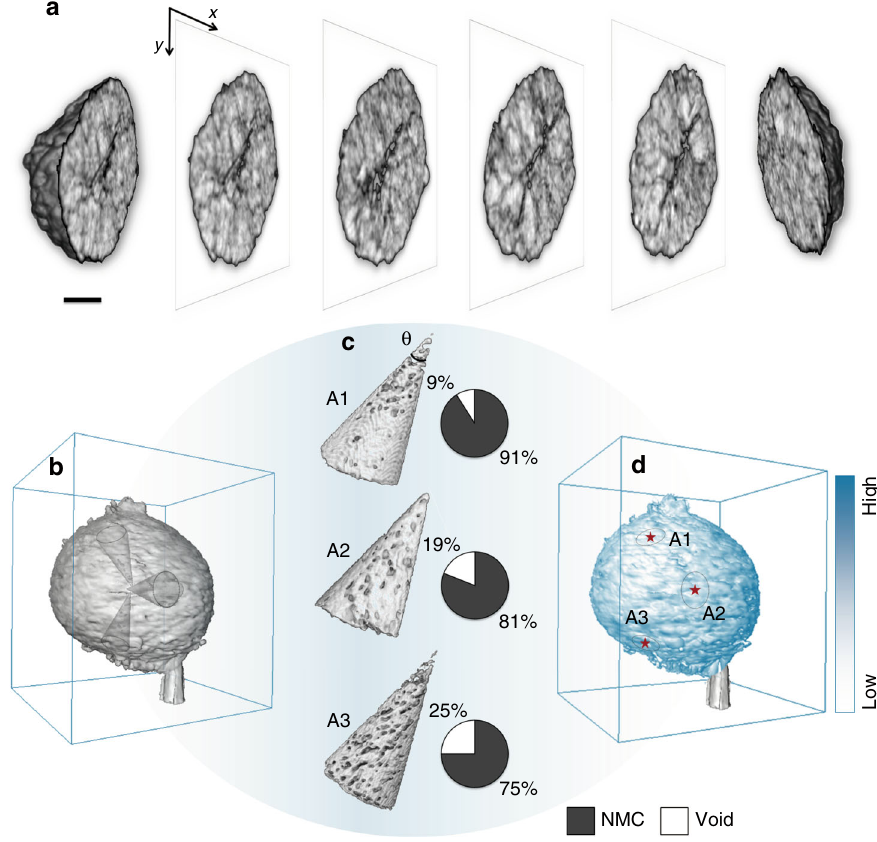
Fig. 2 Structural complexity within a charged NMC811 secondary particle. a 3D rendering of the tomographic data over the particle with the perspective views of a few virtual slices through different depths displayed in the center. b The three cone-shape cutout regions from the nano-tomography data. c Schematic of the local porosity, which is de fi ned by the volume ratio of the void within the respective cone regions. d The calculated porosity map, which shows the porosity value assigned to the surface of particle. The angle θ can be tuned to balance the signal-to-noise and the lateral resolution. The presented maps are based on the calculation with θ set to be 3 o . The scale bar in a is 5 μ